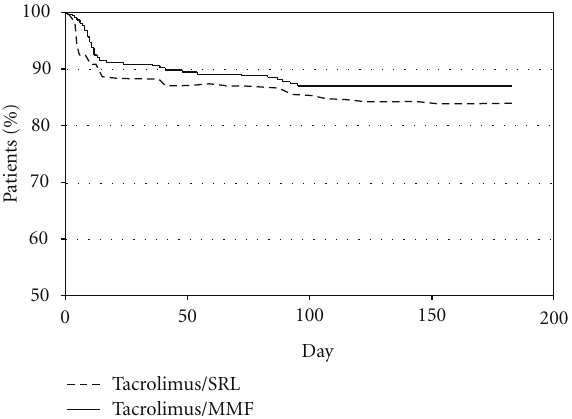
Figure 3: Estimated rate of patients free from biopsy-confirmed acute rejection (Kaplan-Meier method). The estimated rate of patients free from BCAR (Kaplan-Meier method) at 6 months was 83.8% in the Tac/SRL group and 87.1% in the Tac/MMF group (di ff erence between groups − 3.0%; 95% confidence interval: − 8.9% to 2.4% [Greenwood